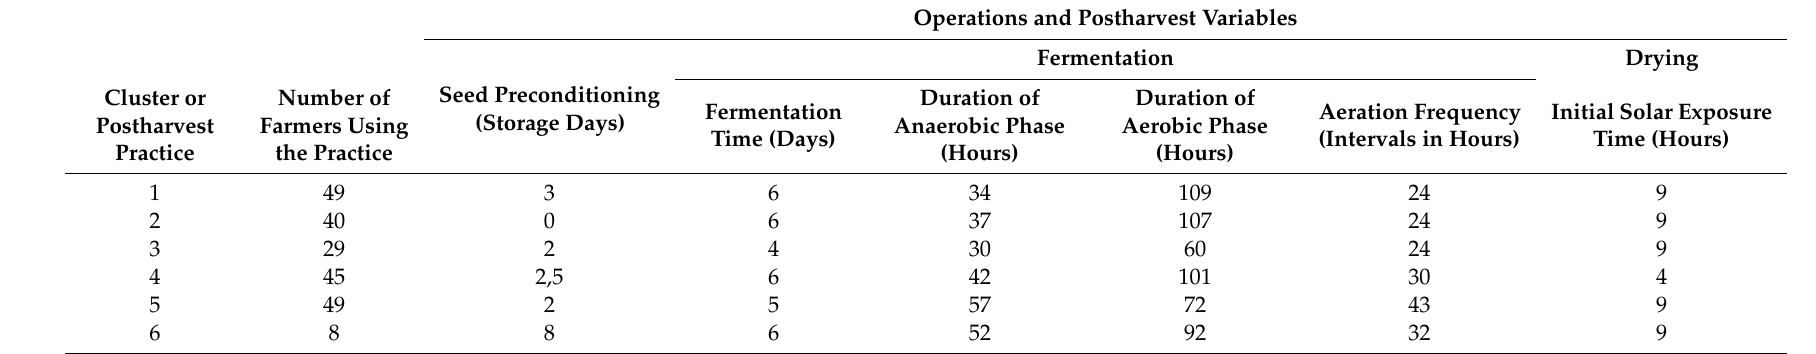
Table 1. Groups of farmers by similarity of postharvest processing practices.